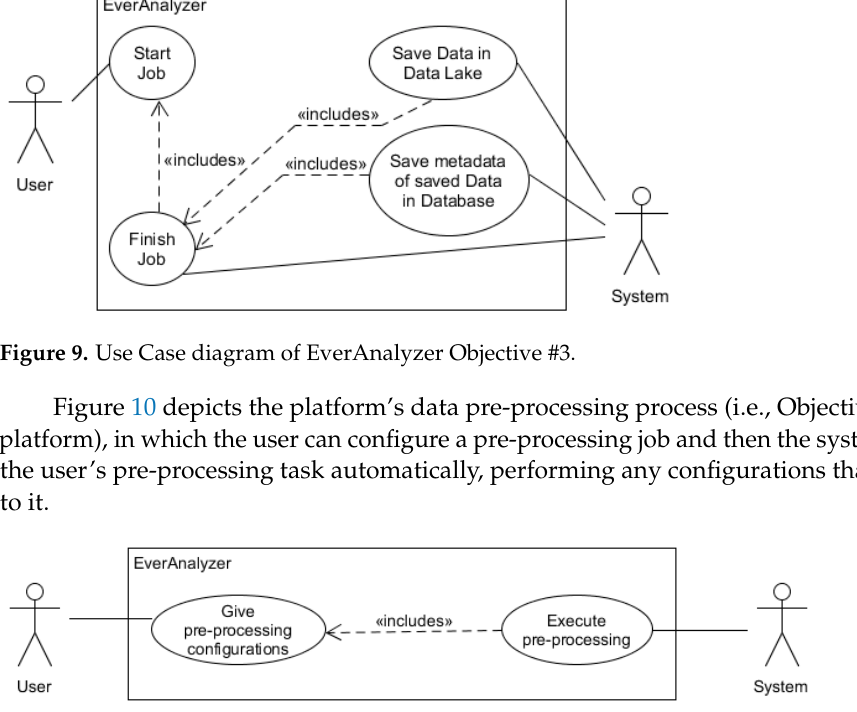
Figure 8. Use Case diagram of EverAnalyzer Objective #2.